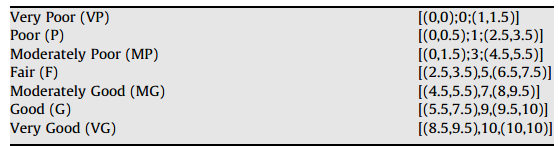
Table 1 Definition of linguistic variables for the ratings